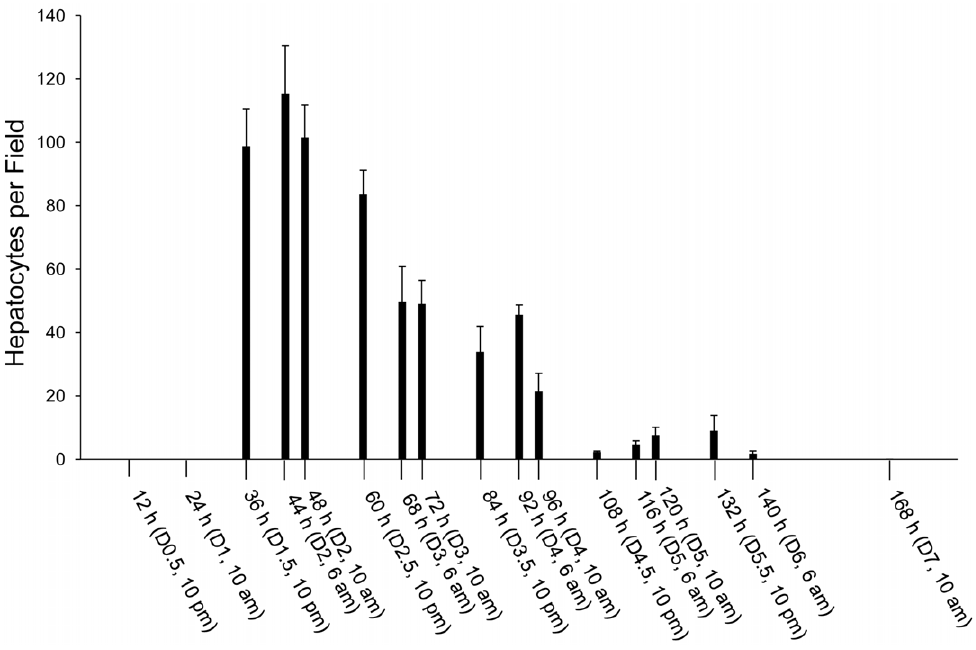
Figure 2. Hepatocyte proliferation induced by partial hepatectomy (PH). Mice were subjected to PH and sacrificed at the indicated time points. Ki-67 immunostaining was performed with formalin-fixed and paraffin-embedded liver sections. Ki67–positive hepatocytes were counted at 200 6 magnification in 5 randomly chosen fields per section. The results are shown as means per field 6 SD (n=3 mice per time point).